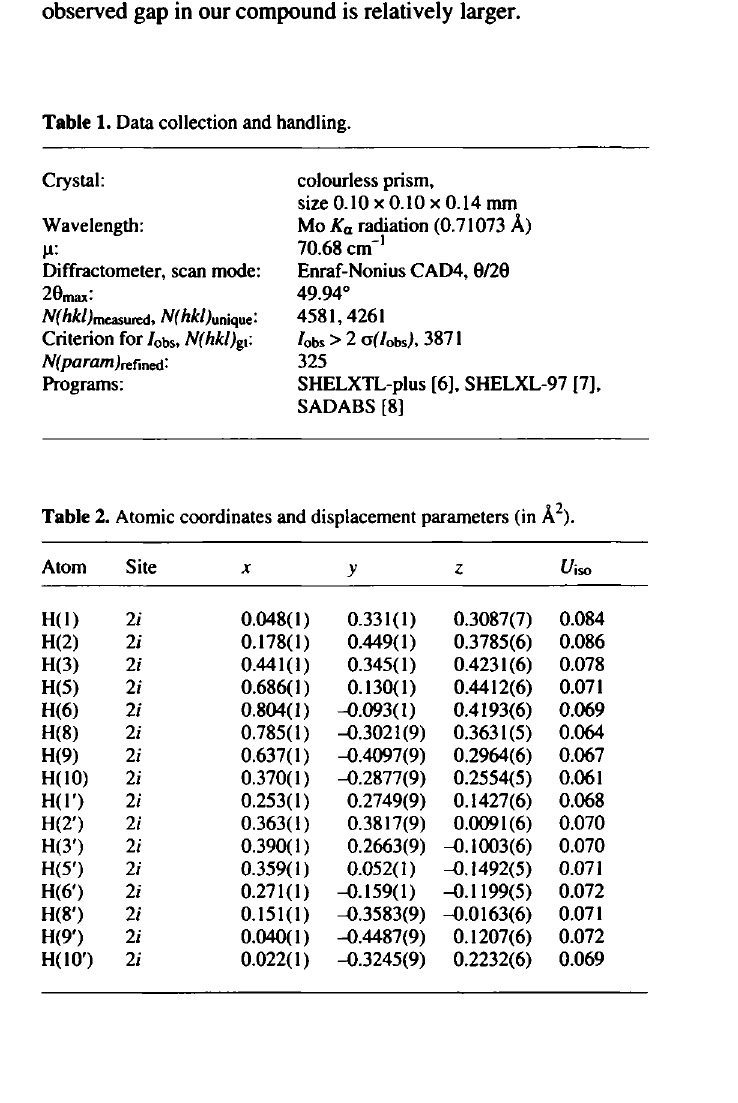
Table 1. Data collection and handling.